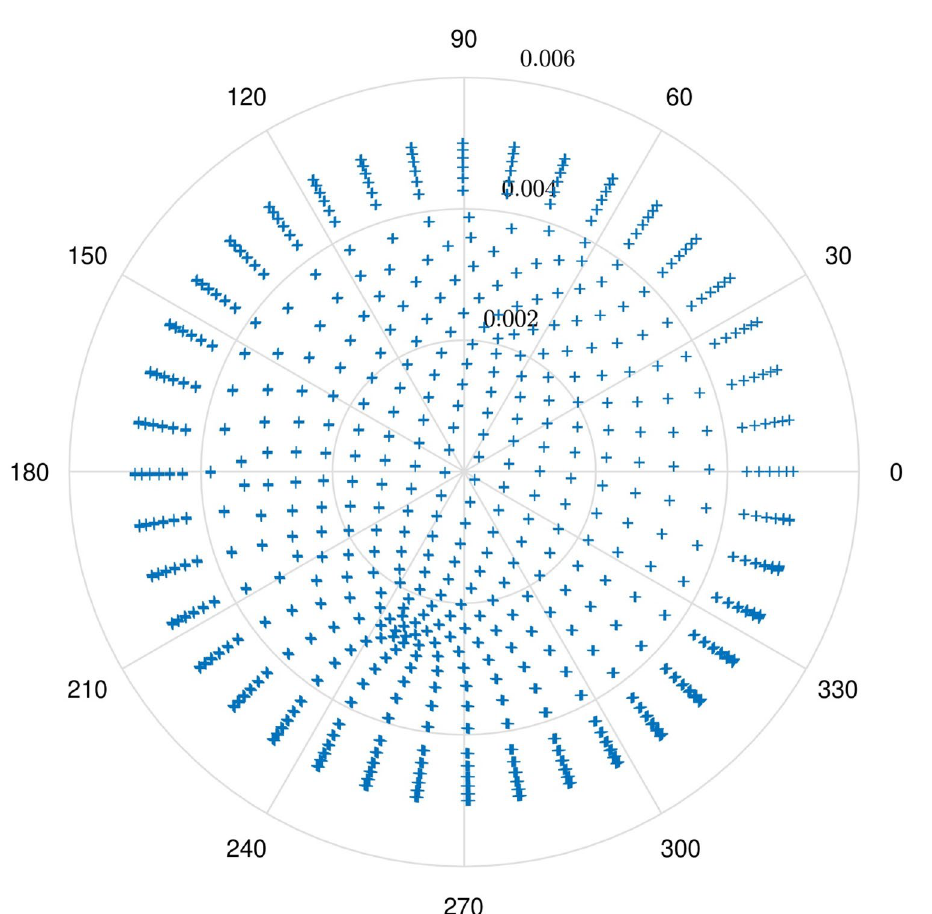
Figure 3. The cross-section of learning